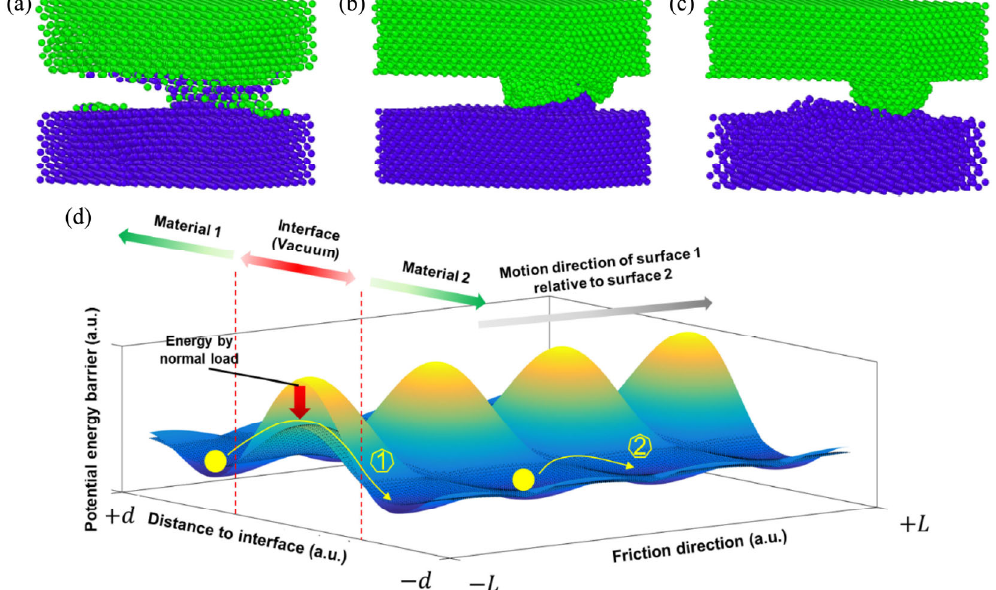
Fig. 4 Single asperity wear situation after the third friction contact for (a) the Al–Al fretting interface, (b) the diamond–diamond fretting interface, and (c) the diamond (upper) –Si (lower) fretting interface, (d) the illustrative description of the atomic-scale deformation (bond deformation energy) and the interfacial attachment (bond dissociation energy)—Process 1: Atom transfer between the surfaces; Process 2: Atom inner-surface